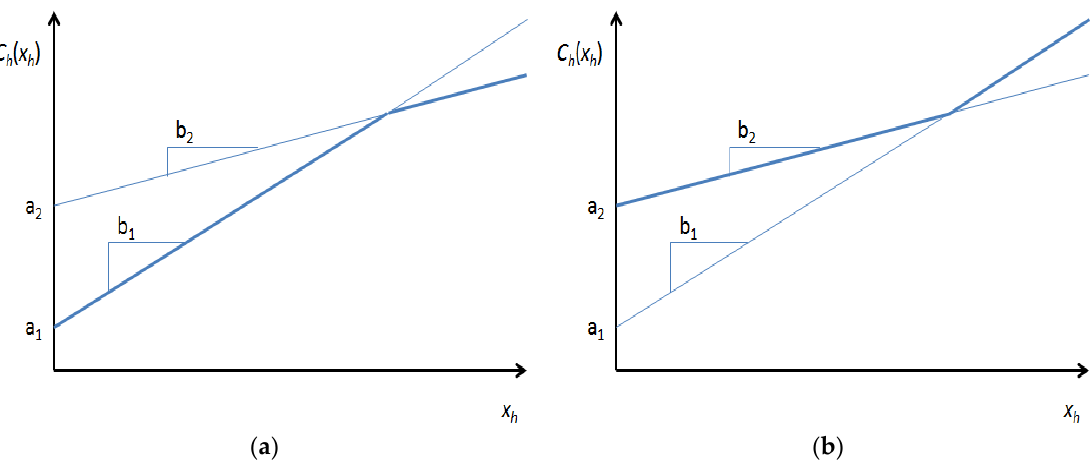
Figure 2. Illustration of the piecewise affine price model. ( a ) Concave (min) configuration, ( b ) Convex (max) configuration. Note: In most cases, either the parameter a 1 or a 2 will be equal to zero.